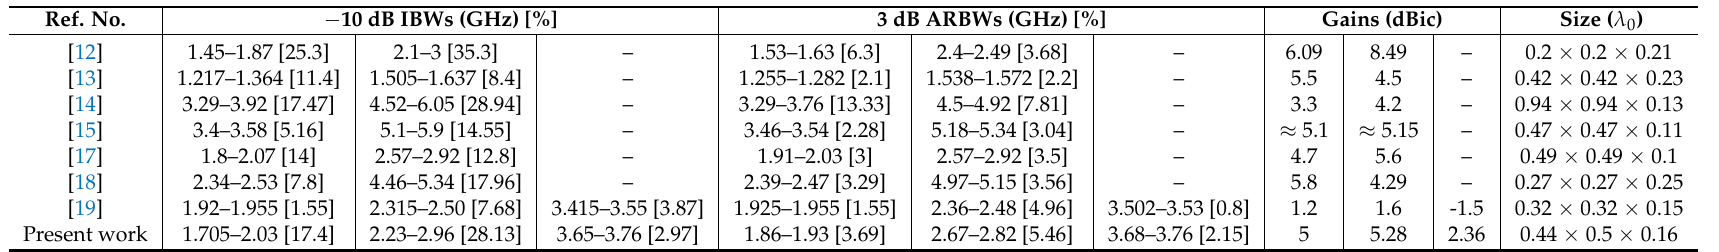
Table 1. Comparison of the proposed DRA with earlier works. Impedance bandwidths (IBWs), axial ratio bandwidths (ARBWs). Ref.